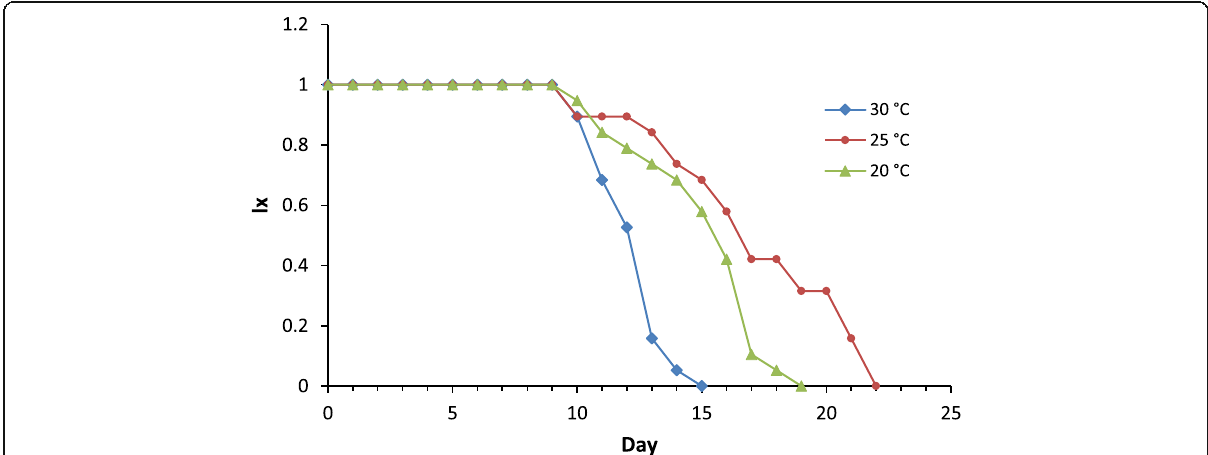
Fig. 1 Survival rate ( lx ) of Aphidius matricariae parasitizing Schizaphis graminum at various